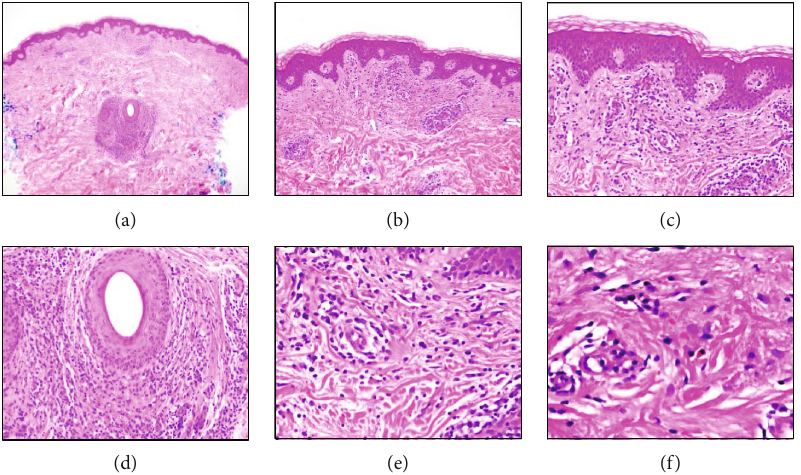
Figure 4: (a) A low-power view showing mild upper dermal perivascular and perifollicular in fl ammation (H&E 40 magni fi cation), (b) basketweave corni fi ed layer and a upper dermal perivascular and interstitial in fl ammatory in fi ltrate (H&E 100 magni fi cation), (c) closer view of the perivascular and interstitial in fl ammatory in fi ltrate without signi fi cant interface or epidermal abnormality (H&E 200 magni fi cation), (d) closer view of the perifollicular in fl ammation (H&E 200 magni fi cation), (e) closer view of the dermal in fl ammatory in fi ltrate of mostly small lymphocytes and a few eosinophils, consistent with drug reaction (H&E 400 magni fi cation), and (f) high-power view of the dermal in fl ammatory in fi ltrate of lymphocytes and a few eosinophils (H&E 600 magni fi